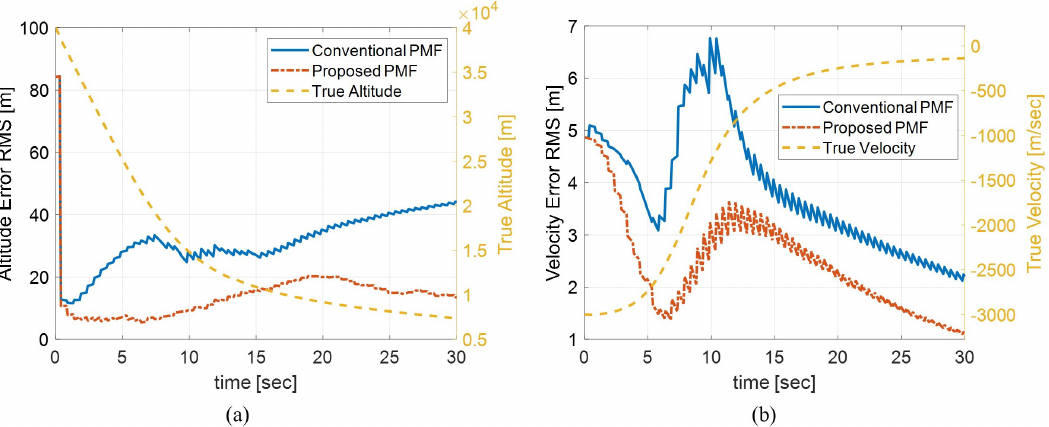
Figure 6. Comparison of the estimation errors between the conventional PMF, the proposed PMF for two dimensional body fall problem ( a ) altitude estimation error ( b ) velocity estimation